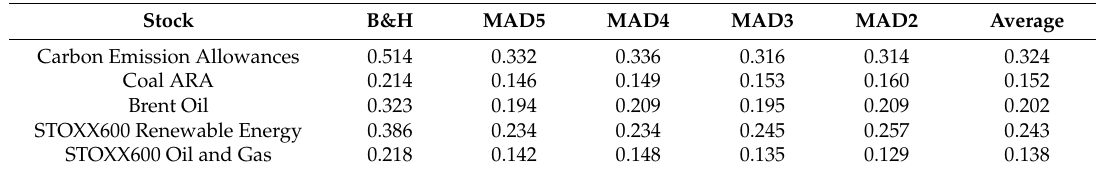
Table A11. Annualized daily (every other month) volatility of MAD2–MAD5 (D = every other month, 5, 4, 3, 2, are the numbers of observations in rolling window), average annualized